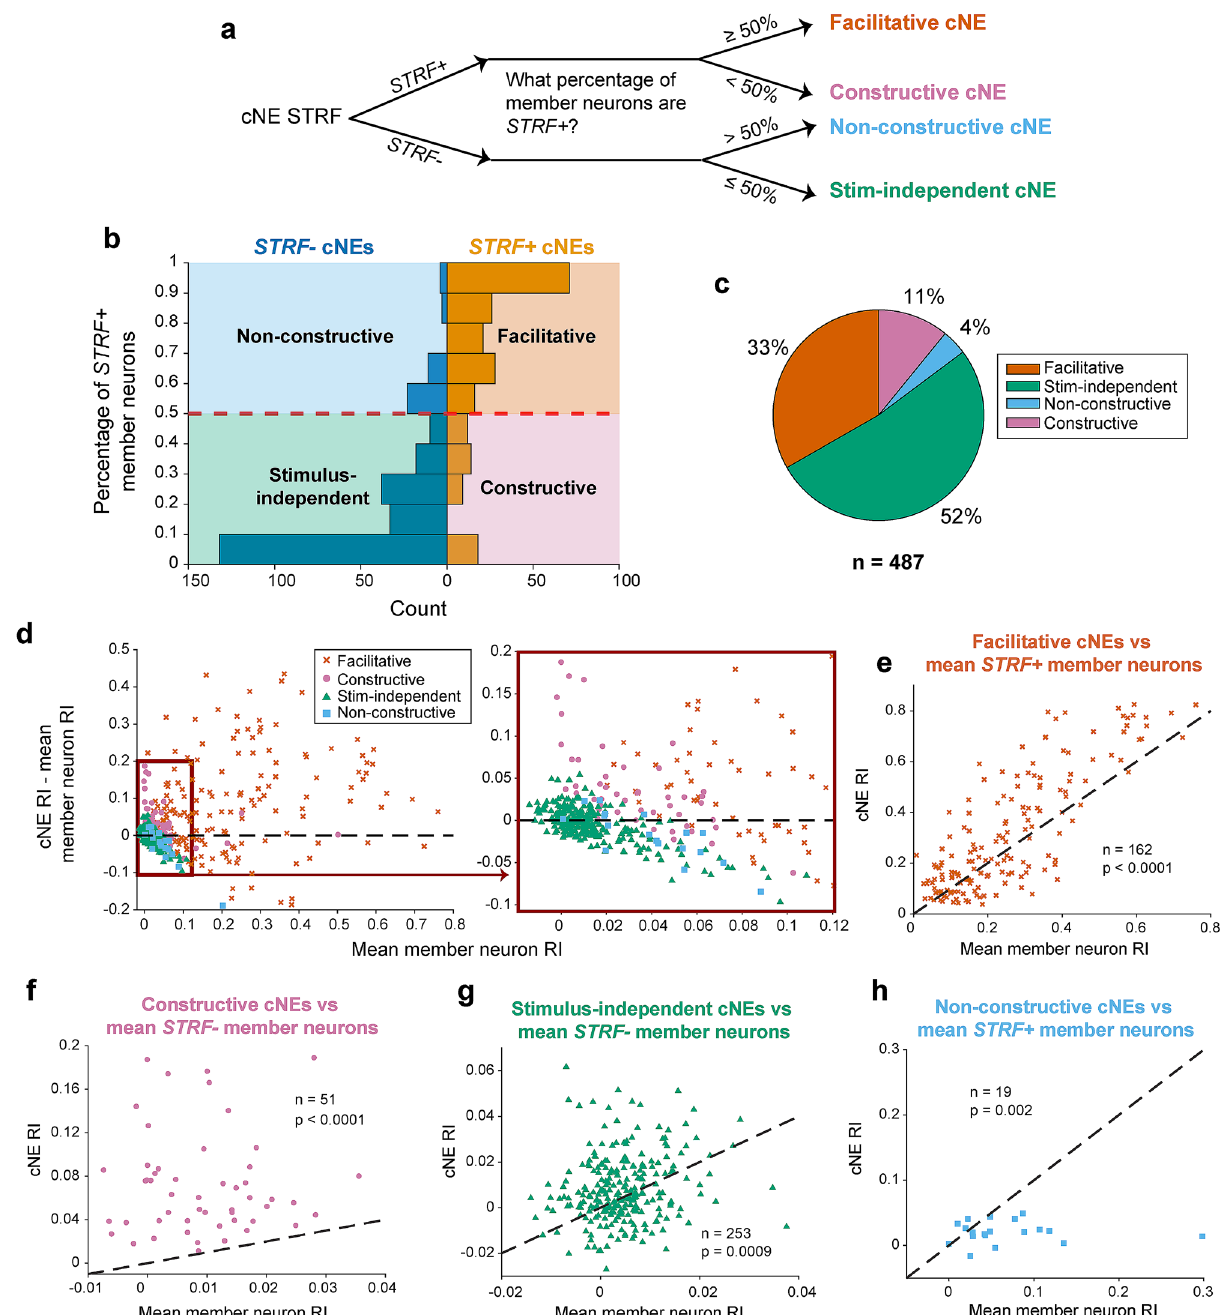
Figure 3. Categorization of cNE groups. ( a ) Flow chart illustrating how cNEs were categorized. ( b ) Histogram of cNE categories. ( c ) Pie chart illustrating the breakdown in percentages of the four different categories of cNEs. ( d ) (Left) Mean of the difference between cNE Reliability Index (RI) and member neuron RI vs mean RI of all member neurons. Only facilitative cNEs exist outside the red square, apart from a few exceptions. (Right) Enlarged version of left graph, indicated by the red square. Constructive cNEs mostly fall above the black dashed line (i.e., cNE RI > member neuron RI), stimulus-independent cNEs fall on either side of the black dashed line and are mostly clustered at low values around 0, while non-constructive cNEs cluster below the black dashed line. The four different groups form different clusters although with some overlap. ( e ) RI between facilitative cNEs and the mean RI of STRF + member neurons. ≈ 67% of cNEs had higher RIs than that of their member neurons. ( f ) Same as ( e ), but for stimulus-independent cNEs and STRF− neurons. ≈ 56% of cNEs had higher RIs than that of their STRF− member neurons. ( g ) Same as ( e ), but for constructive cNEs and STRF− member neurons. 100% of cNEs had higher RIs than that of their member neurons. ( h ) Same as ( e ), but for non-constructive cNEs and STRF + member neurons. ≈ 21% of cNEs had higher RIs than that of their member neurons. ( e – h ) Wilcoxon signed-rank